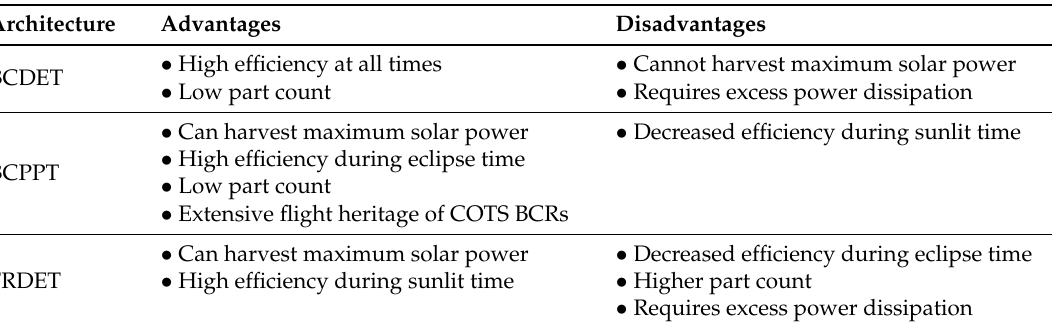
Table 2. Comparison of architecture